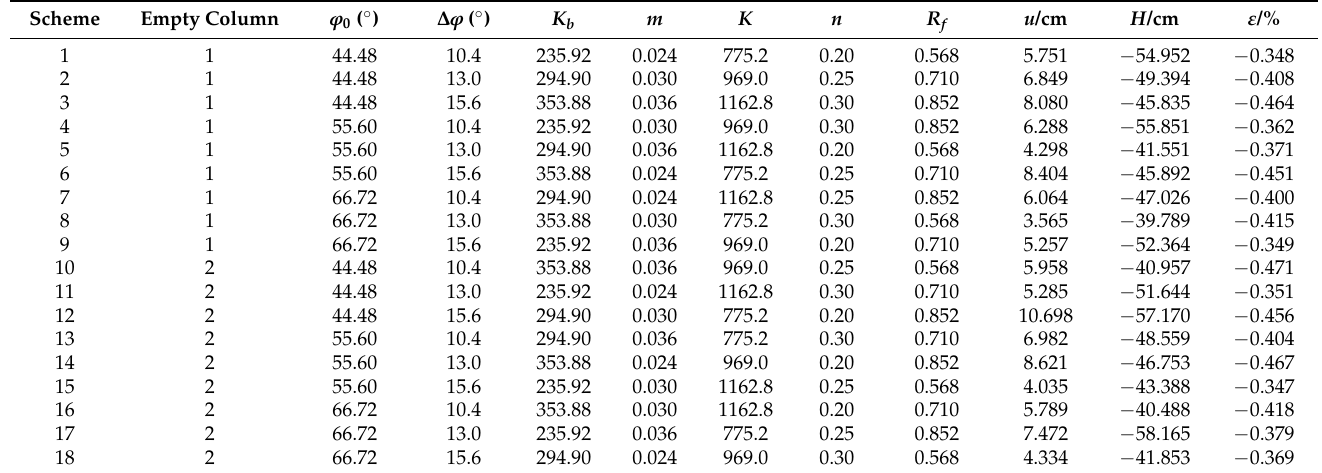
Table 5. Orthogonal test scheme and calculation results of main rockfill zone.